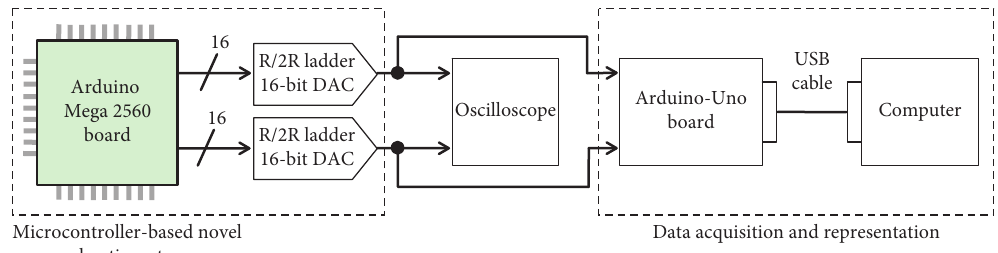
Figure 16: Scheme of the experiment on microcontroller-based implementation of system (2).